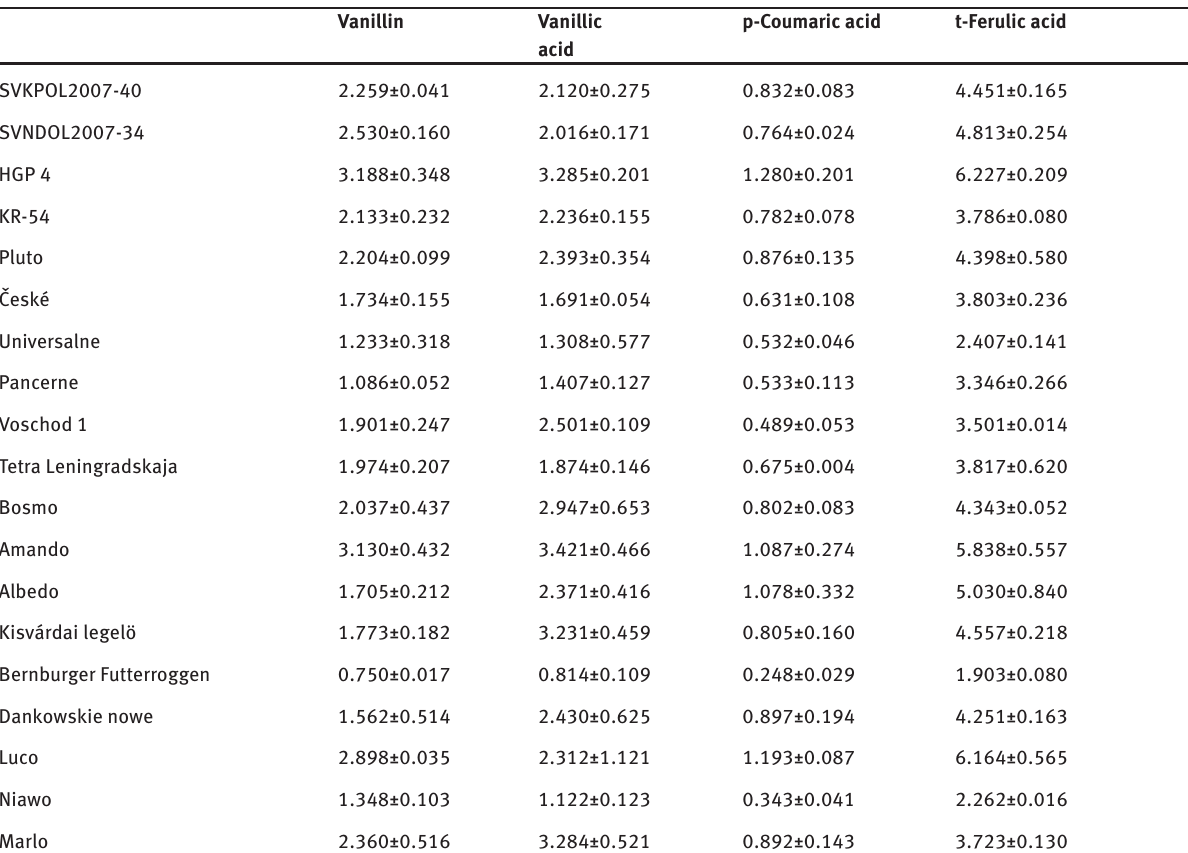
Table 3: Contents (mg/kg) of four phenolic compounds in grain extracts from 19 rye